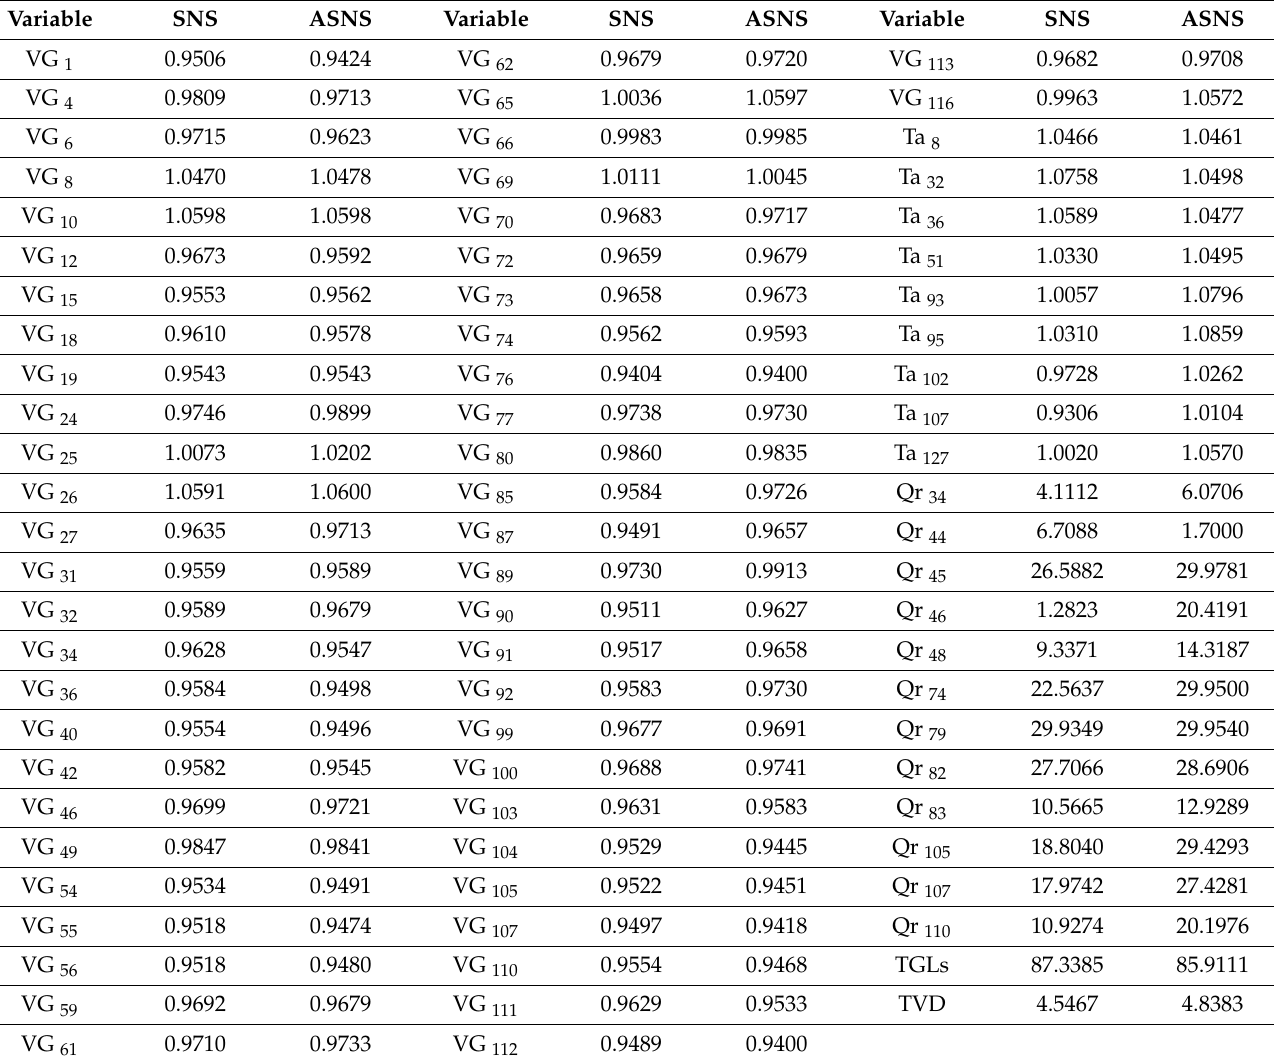
Table 9. Optimal results for Case 1 of the IEEE 118-bus